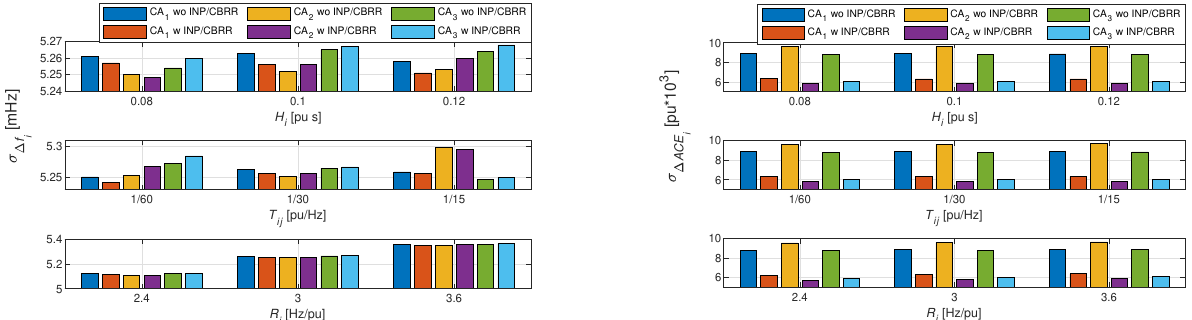
Figure 14. Average values of σ ∆ f INP/CBRR” is without and “w INP/CBRR” is with the INP and